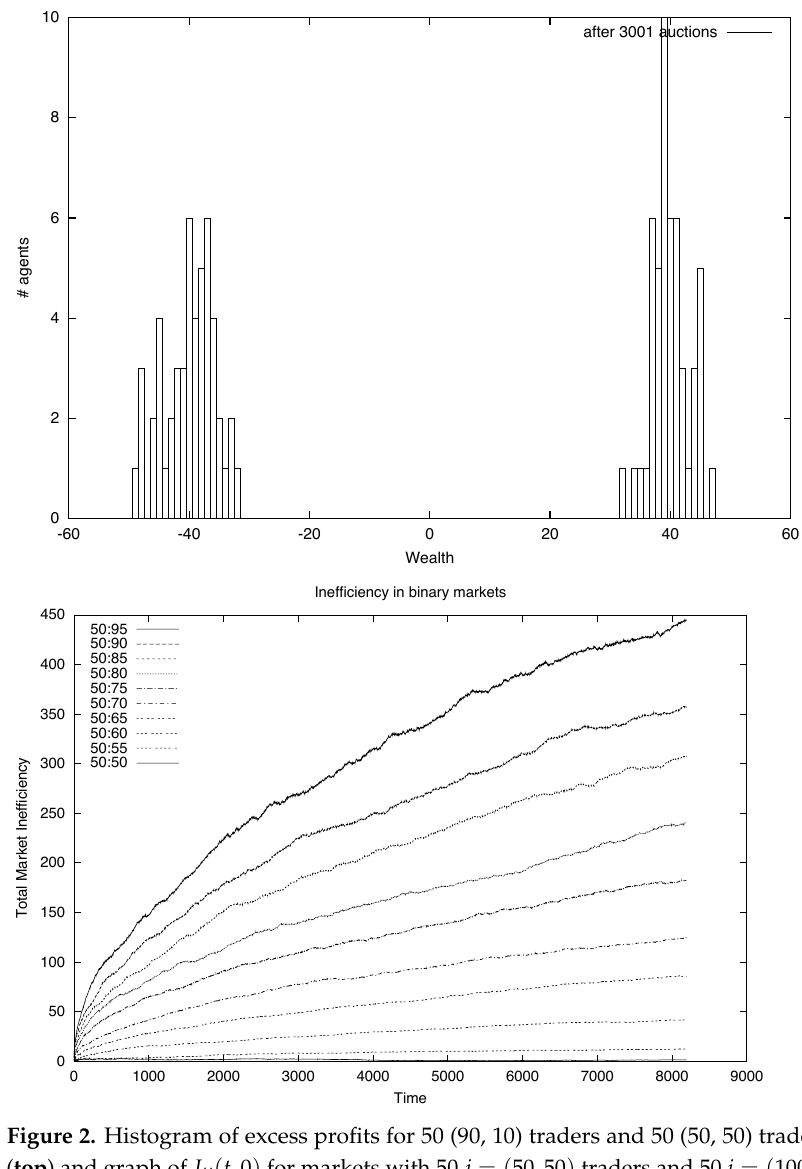
Figure 2. Histogram of excess profits for 50 (90, 10) traders and 50 (50, 50) traders after 3001 ticks ( top ) and graph of I ij ( t ,0 ) for markets with 50 j = ( 50,50 ) traders and 50 i = ( 100 − x , x ) traders. In the legend, 50:65, for example, corresponds to a market with 50 noise traders and 50 (65:35)